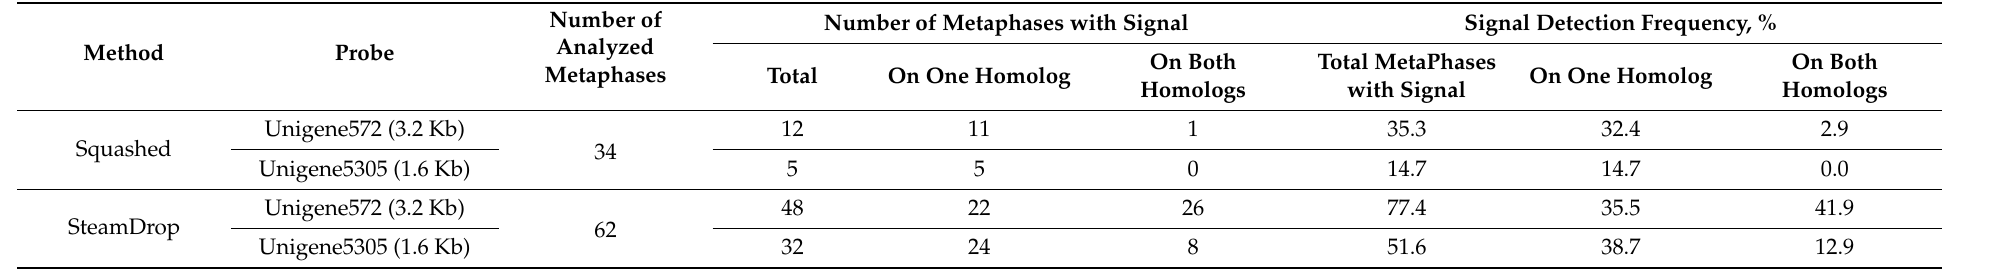
Table 2. Influence of the method of chromosome slide preparation on the frequency of signal